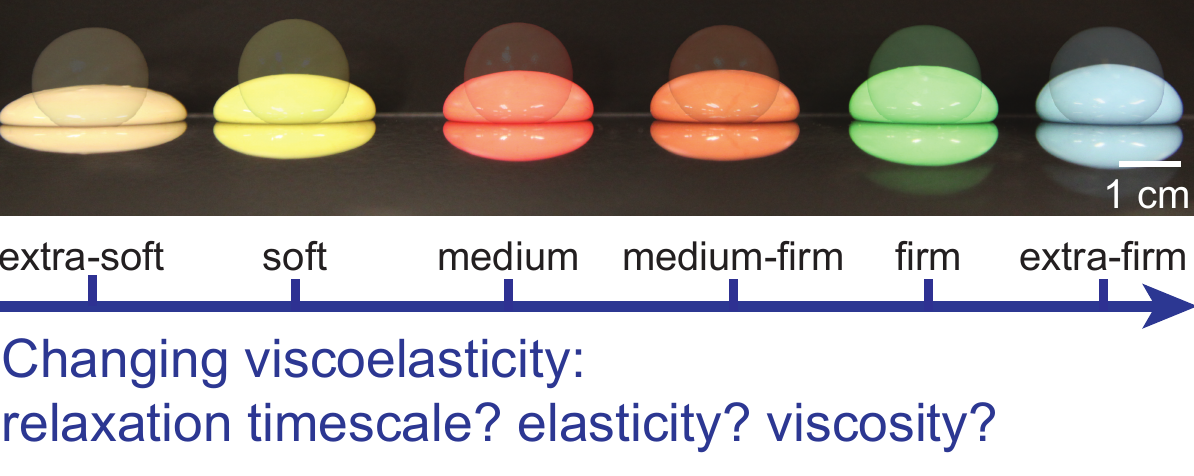
Figure 2: Polysilicone materials designed for a range of user experience from “extra-soft” (left) to “extra-firm” (right). But this naming convention from the supplier does not clarify what viscoelastic features change across the spectrum of materials: elasticity, or viscosity, or relaxation timescales? "(Photos taken 10 minutes after initial spherical